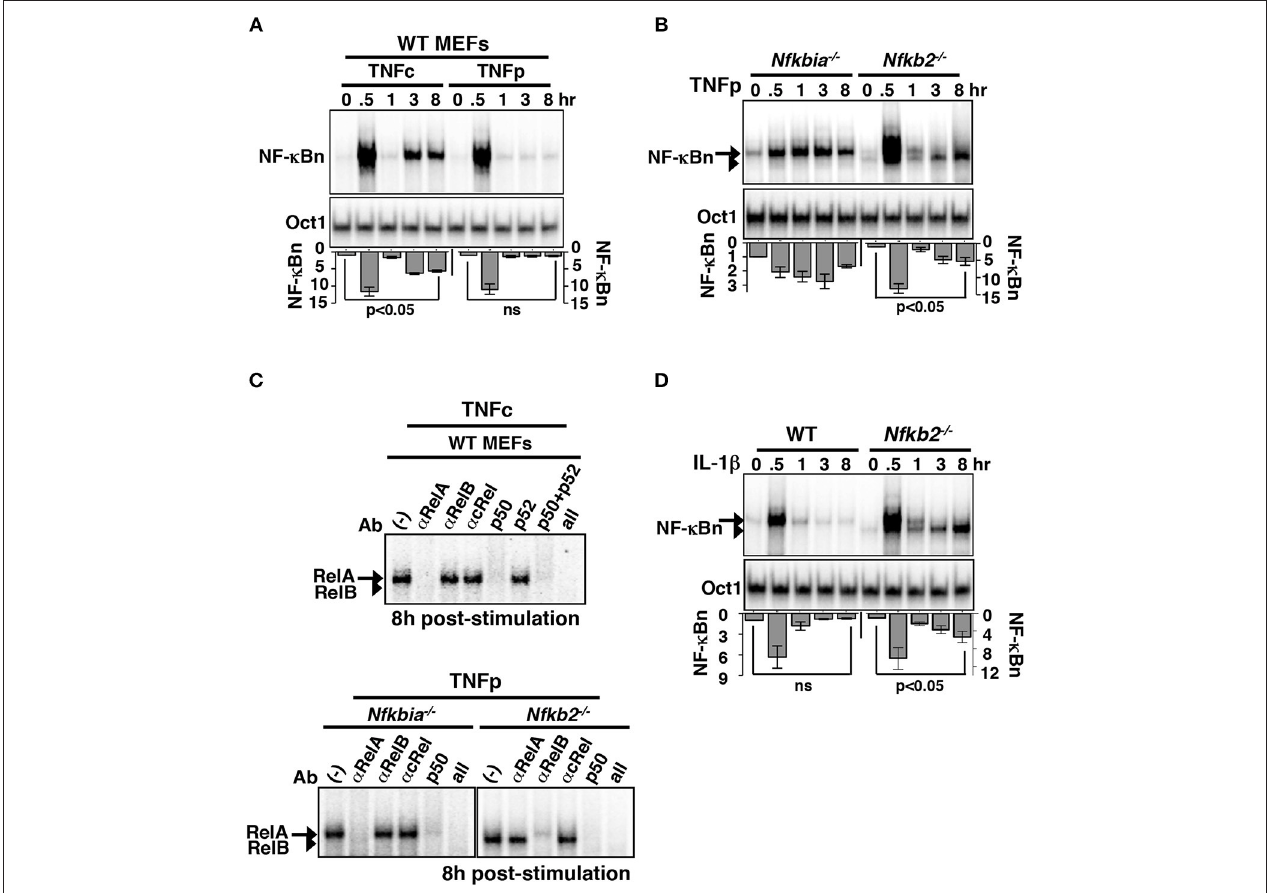
FIGURE 2 | Brief TNF stimulation of Nfkb2 − / − MEFs induce an additional late NF- κ B activity composed of RelB:p50 heterodimers. (A) WT MEFs were subjected to TNFc or TNFp treatments, cells were harvested at the indicated time-points after the commencement of stimulations, and NF- κ Bn DNA binding activities were resolved in EMSA (top panel). DNA binding activity of Oct1 served as a loading control (middle panel). Bottom: signals corresponding to NF- κ Bn were quantified from four independent experiments and presented in relation to the basal activity in a bargraph. Statistical significance was evaluated using Student’s t test. (B) EMSA comparing NF- κ Bn induced in a time-course in Nfkbia − / − and Nfkb2 − / − MEFs upon TNFp treatment (top panel). As determined in (C) , the arrow and the arrowhead indicate RelA-containing and RelB-containing NF- κ B complexes, respectively. Bottom: quantitative analysis of the total NF- κ Bn activities from four experimental replicates. (C) Composition of the NF- κ Bn activities that persisted after 8h of TNFp treatment in Nfkbia − / − and Nfkb2 − / − MEFs, was determined in the shift-ablation assay. Antibodies against the indicated NF- κ B subunits were used for ablating the respective DNA binding complexes in EMSA. Data represents two independent experiments. (D) Time-course analysis of NF- κ B DNA binding activity induced upon IL-1 β treatment of WT or Nfkb2 − / − MEFs (top panel). Bottom: quantified NF- κ B signal intensities; data represent four experimental replicates. Quantified data presented in this figure are means ±